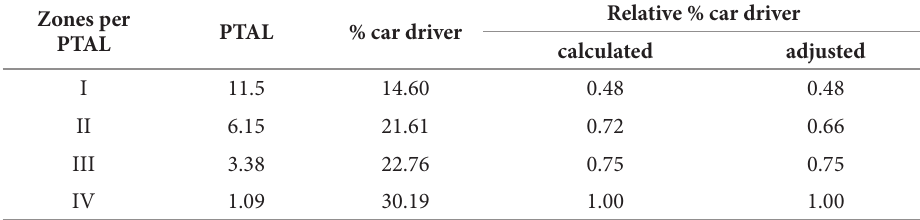
Table 5. Definition of relative % car driver Zones per